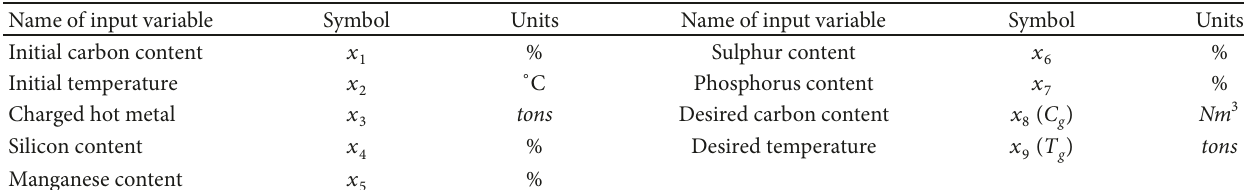
Table 2: Independent input variables of control